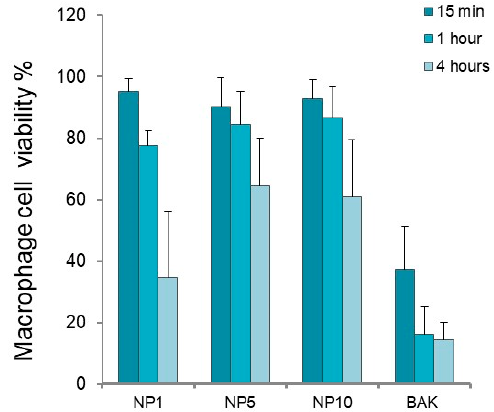
Figure 7. Macrophage cell viability in percentage (coefficient of variation, c.v.) for HEMA/Bayfit-MA copolymer nanoparticles NP1, NP5, and NP10. Benzalkonium chloride 0.005% (BAK) was used as positive control.